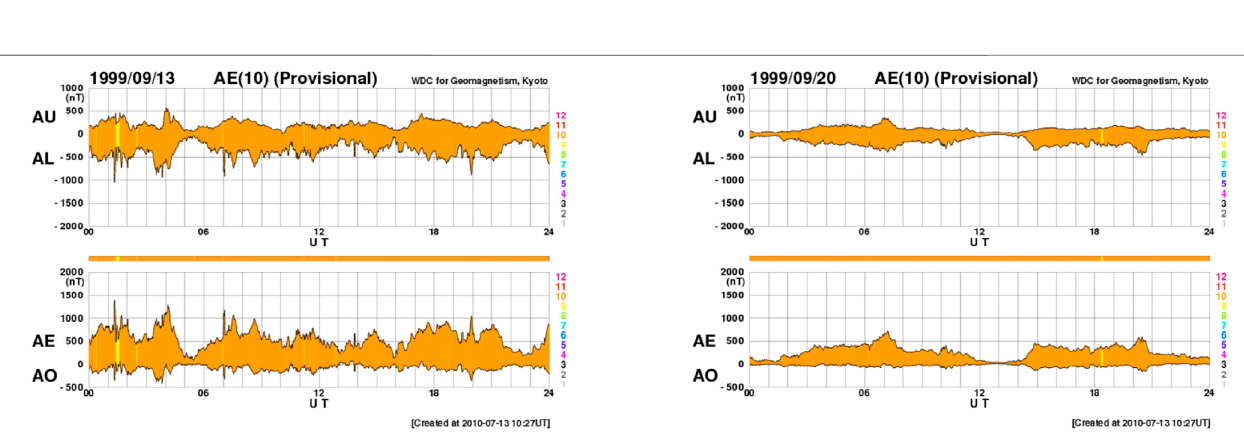
Frontiers in Earth Science |